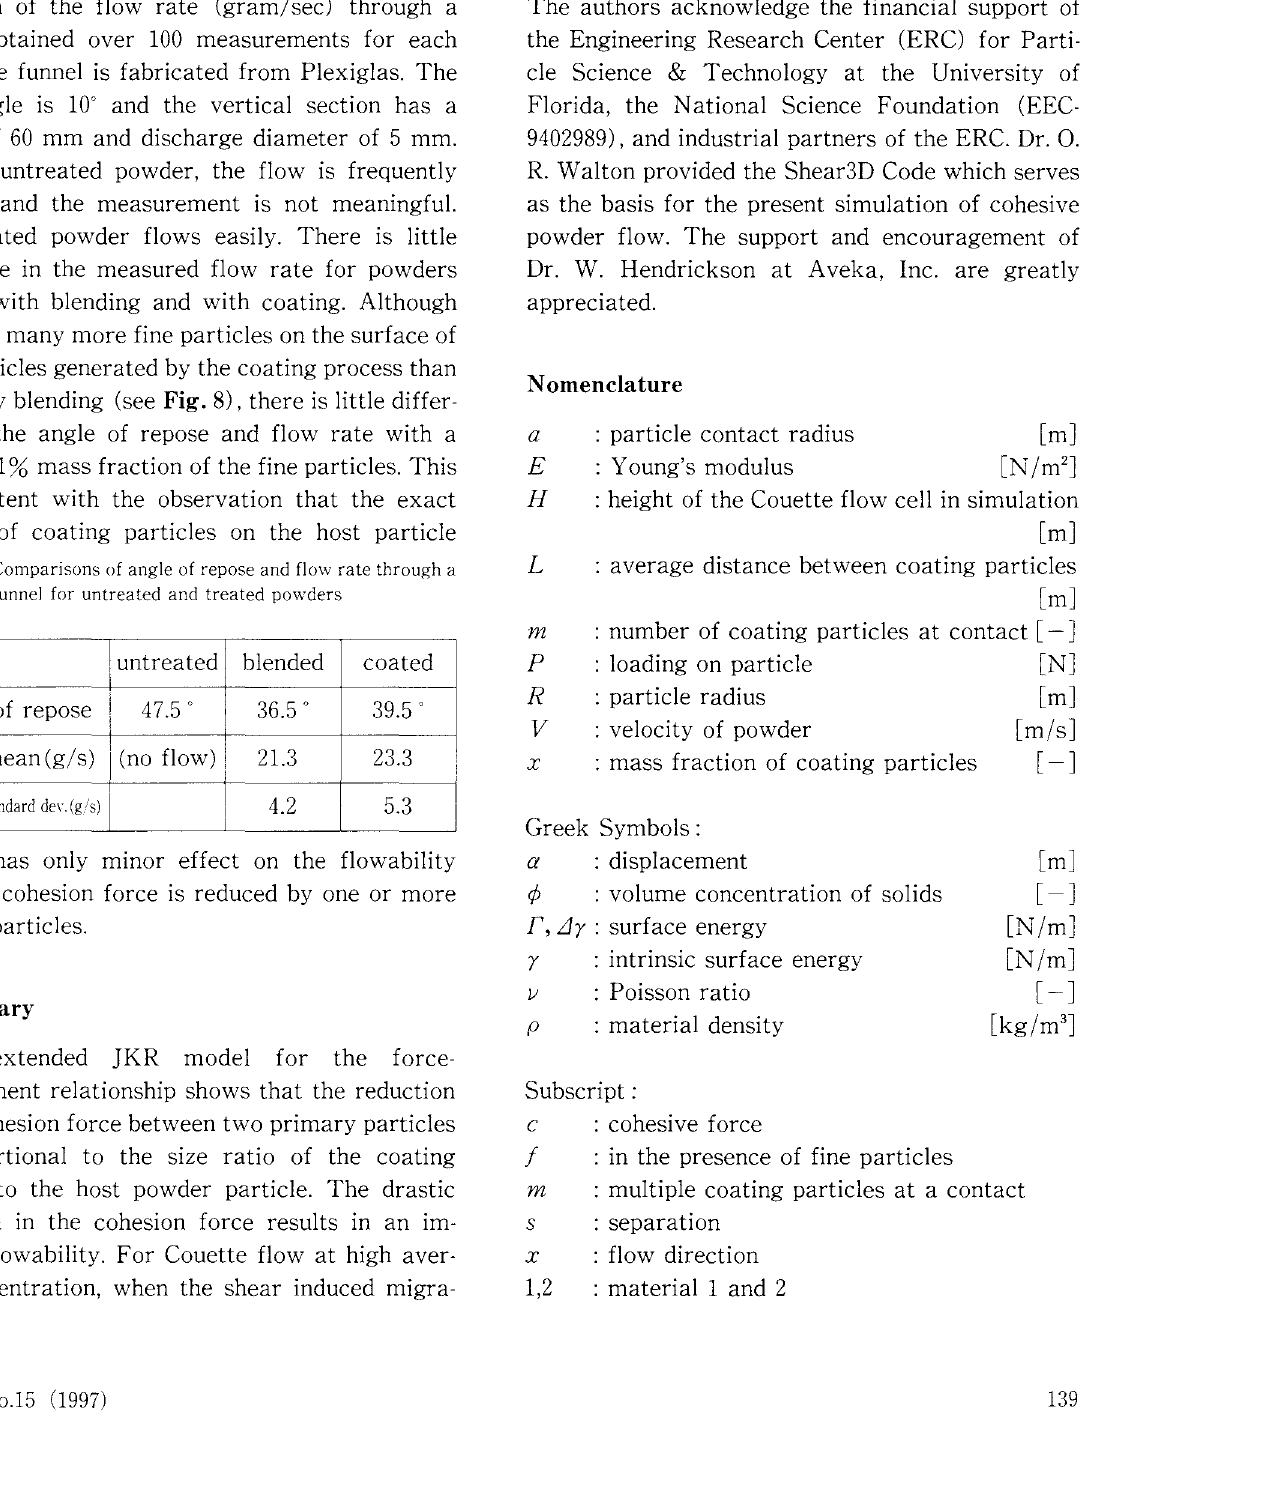
Table. 1 Comparisons of angle of repose and flow rate through a funnel for untreated and treated powders I